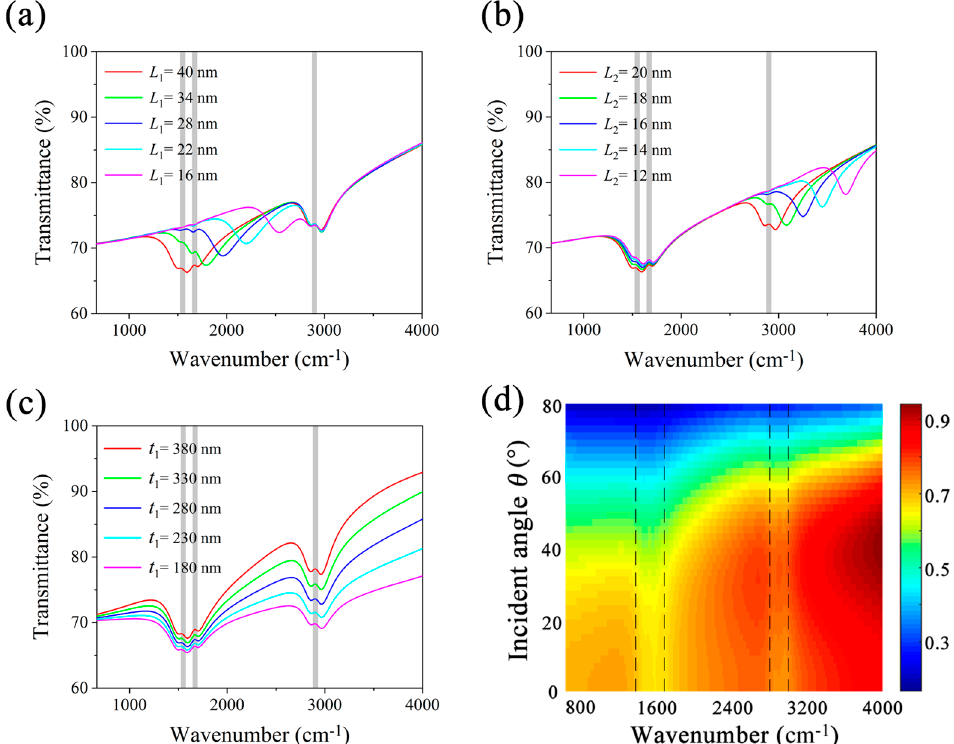
Figure 4. ( a – c ) Transmittance of MRGB covered with protein and lipid molecules under normal TM incidence, for p = 80 nm, t 2 = 500 nm, E F 1 = 0.55 eV, E F 2 = 0.85 eV. ( a ) Using different L 1 values, for L 2 = 20 nm, t 1 = 280 nm. ( b ) Using different L 2 values, for L 1 = 40 nm, t 1 = 280 nm. ( c ) Using different t 1 values, for L 1 = 40 nm, L 2 = 20 nm. Gray vertical bars represent vibrational bands of protein and lipid molecules. ( d ) Transmittance as a function of wavenumber and incident angle θ under TM incidence, where L 1 = 40 nm, L 2 = 20 nm, t 1 = 280 nm, t 2 = 500 nm, p = 80 nm, E F 1 = 0.55 eV, E F 2 = 0.85 eV. Dashed vertical black strips outline the vibrational bands of protein and lipid molecules.